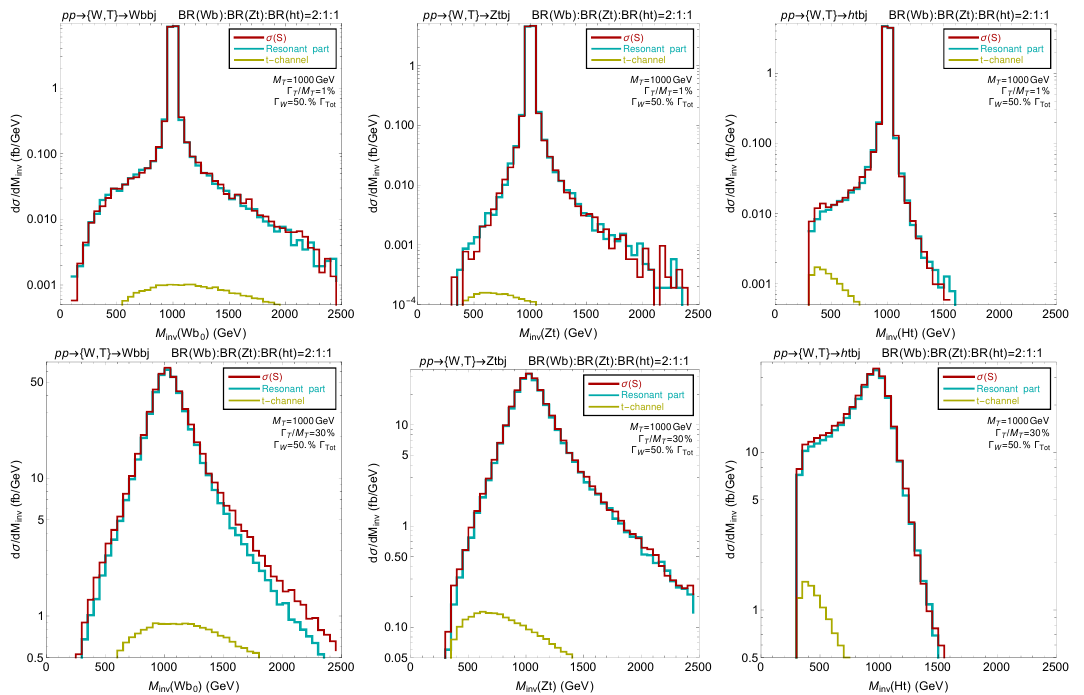
Figure 3 . Individual contributions of the resonant s -channel (teal) and non-resonant t -channel (yellow) diagrams to pp → Wbbj (left), pp → Ztbj (centre) and pp → htbj (right) production, when mediated by the exchange of a vector-like quark T of mass M = 1 TeV in the narrow- T width ( Γ = 1% , top row) and large-width ( Γ = 30% , bottom row) cases. We present T /M T T /M T distributions in the invariant mass of the Wb (left), Zt (centre) and ht (right) systems, and indicate by red lines the full differential cross sections that include both the resonant and non-resonant components, as well as their interference. For all these results, the couplings are fixed as in eq. (3.7) in order to reproduce the branching ratio relation of eq. (3.5). For analogous results for a vector-like quark T of mass M = 2 TeV, we refer to figure 17, while figures 20 and 21 focus on T production T through Zt